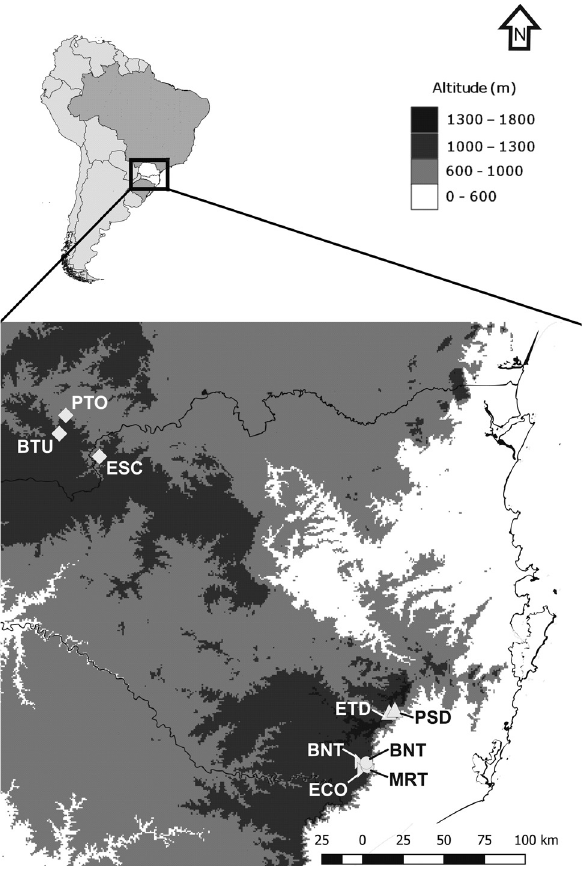
Figure 1 - Geographic distribution of collection locations of four Calibrachoa species: C. eglandulata (triangles); C. sendtneriana (half-diamonds); C. serrulata (circles); and C. spathulata (diamonds). For population codes per species see Table 1.